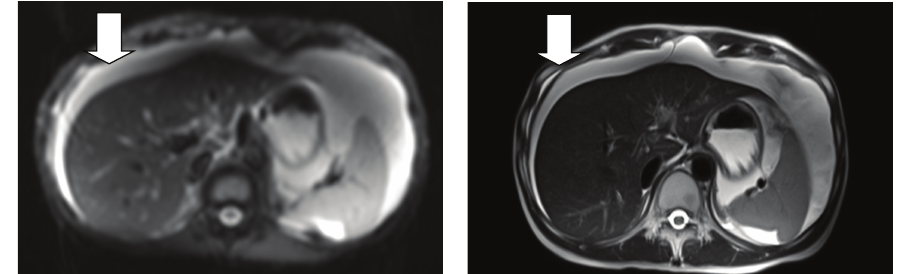
Figure 1: Di ff usion-weighted MRI demonstrating ascites (arrow) in patients with gastric cancer following partial gastrectomy with chemotherapy-associated steatohepatitis.